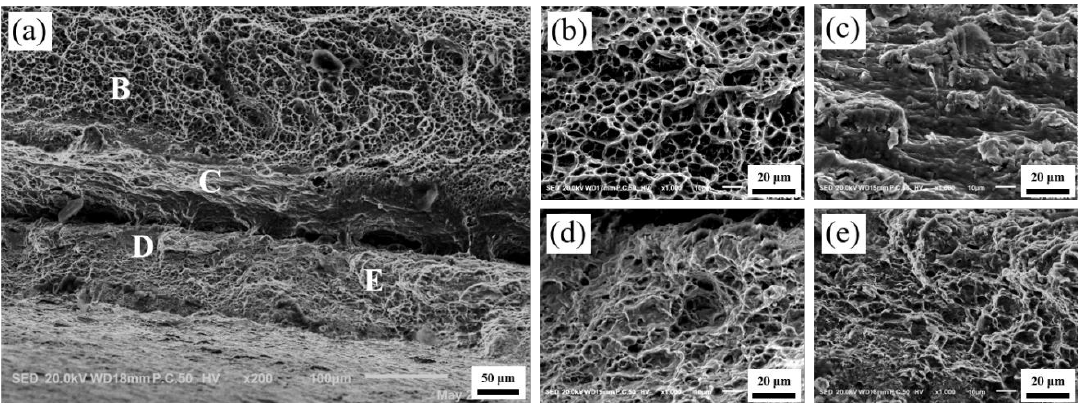
Figure 12. Fractography of the Ti/Al laminated composites in 0° direction after the tensile test. ( a ) Macro-fractography, ( b ) high-resolution fractography (HRF) at position B in Figure 12a, ( c ) HRF at position C in Figure 12a, ( d ) HRF at position D in Figure 12a, ( e ) HRF at position E in Figure 12a.